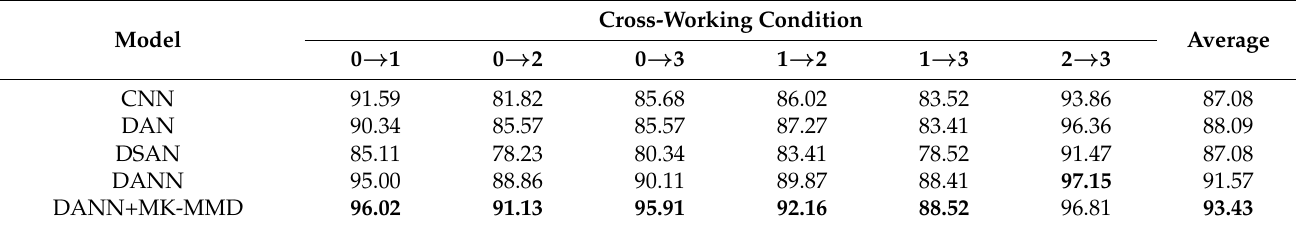
Table 2. Cross-domain classification accuracy of different